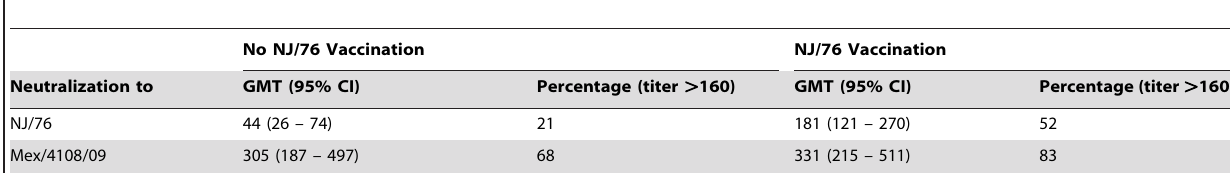
Table 2. Summary of neutralization titers of contemporary sera from subjects with or without a history of having received the NJ/ 76 swine influenza